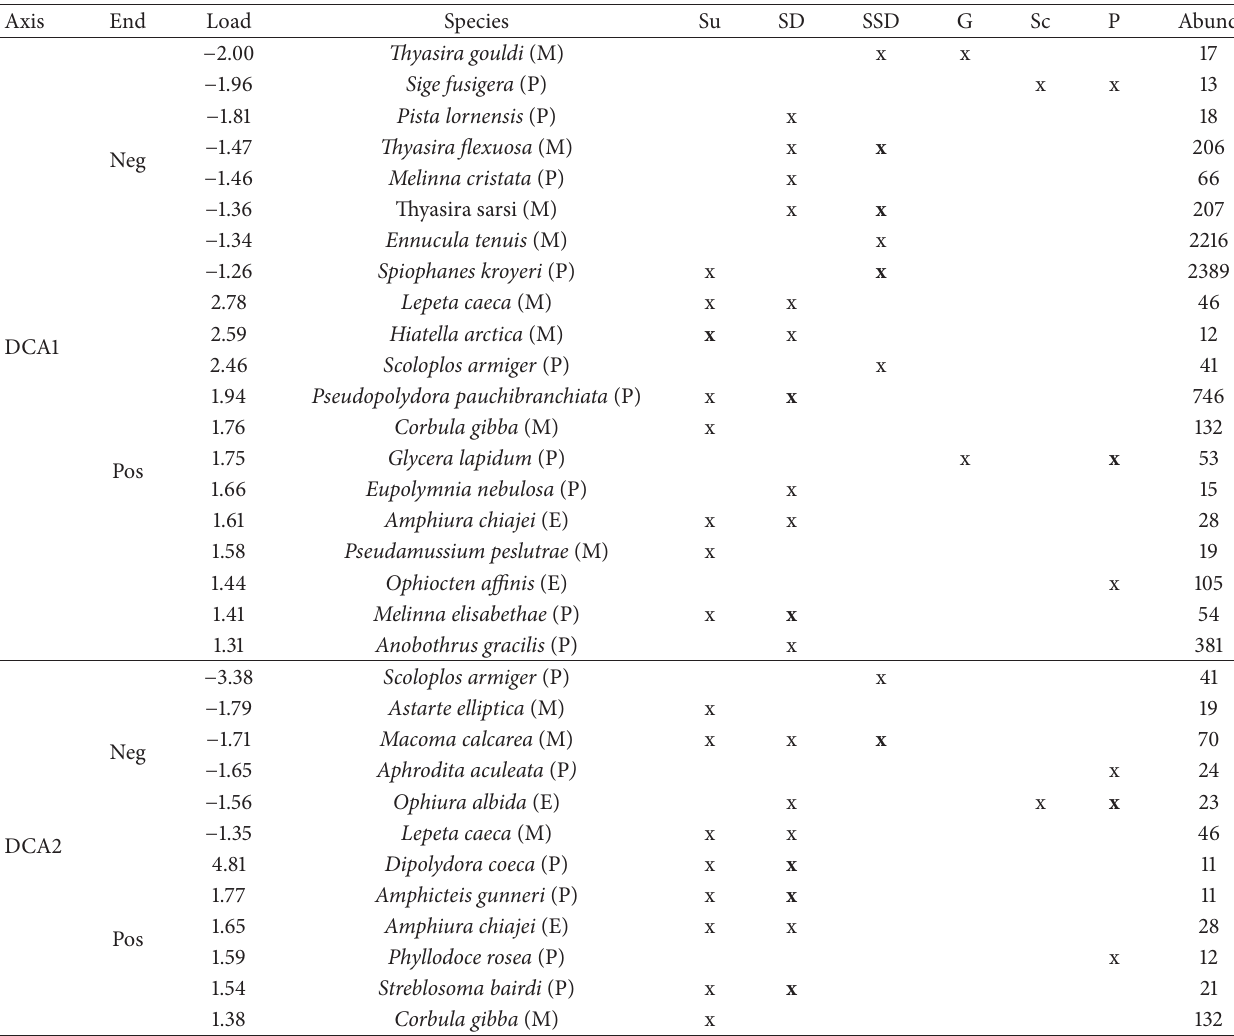
Table 9: Species associated with the negative (Neg) and positive (Pos) extremes of DCA axes 1 and 2, with indication of feeding strategy, species loading on axes (“Load” column), and raw total abundance for each species (“Abund” column). Only species with DCA. 𝑅 32 species loadings with absolute values > 1.25 and with a raw total abundance above 10 were